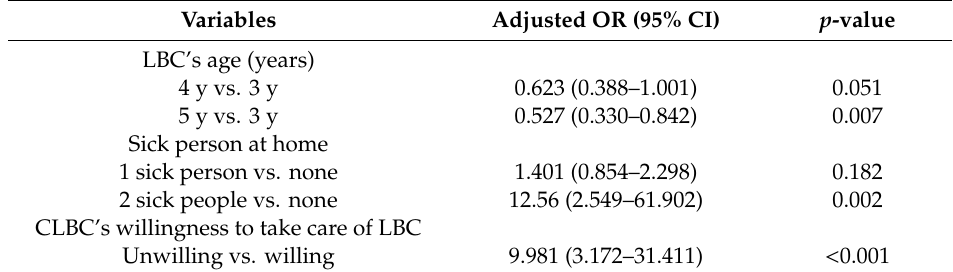
Table 3. Logistic regression model for exploring factors associated with SDQ behavioral problems (n =